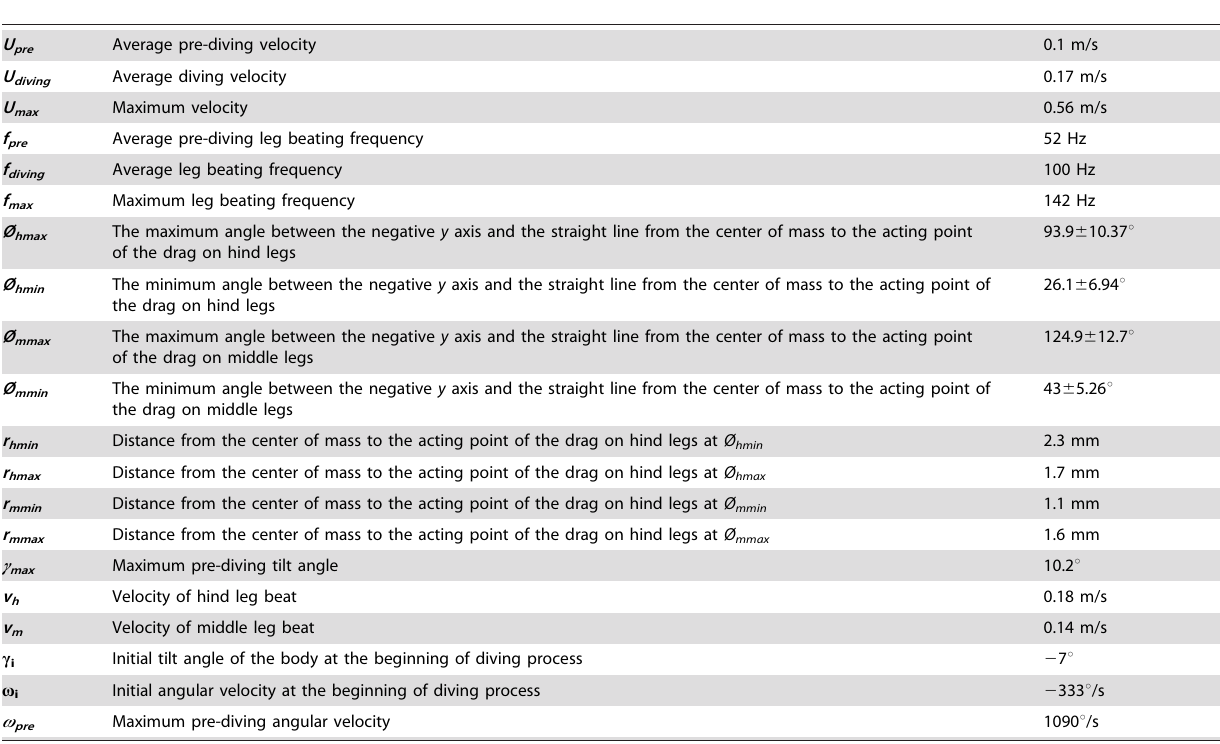
Table 3. Diving parameters obtained from high-speed video analysis.